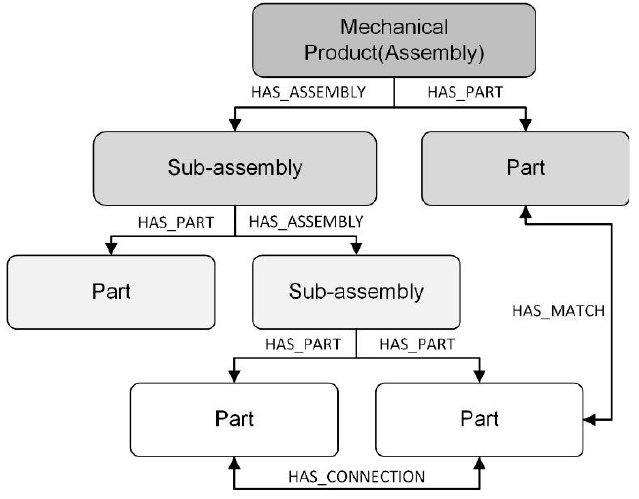
Figure 3. Diagram of the hierarchical structure ontology model of a mechanical product.